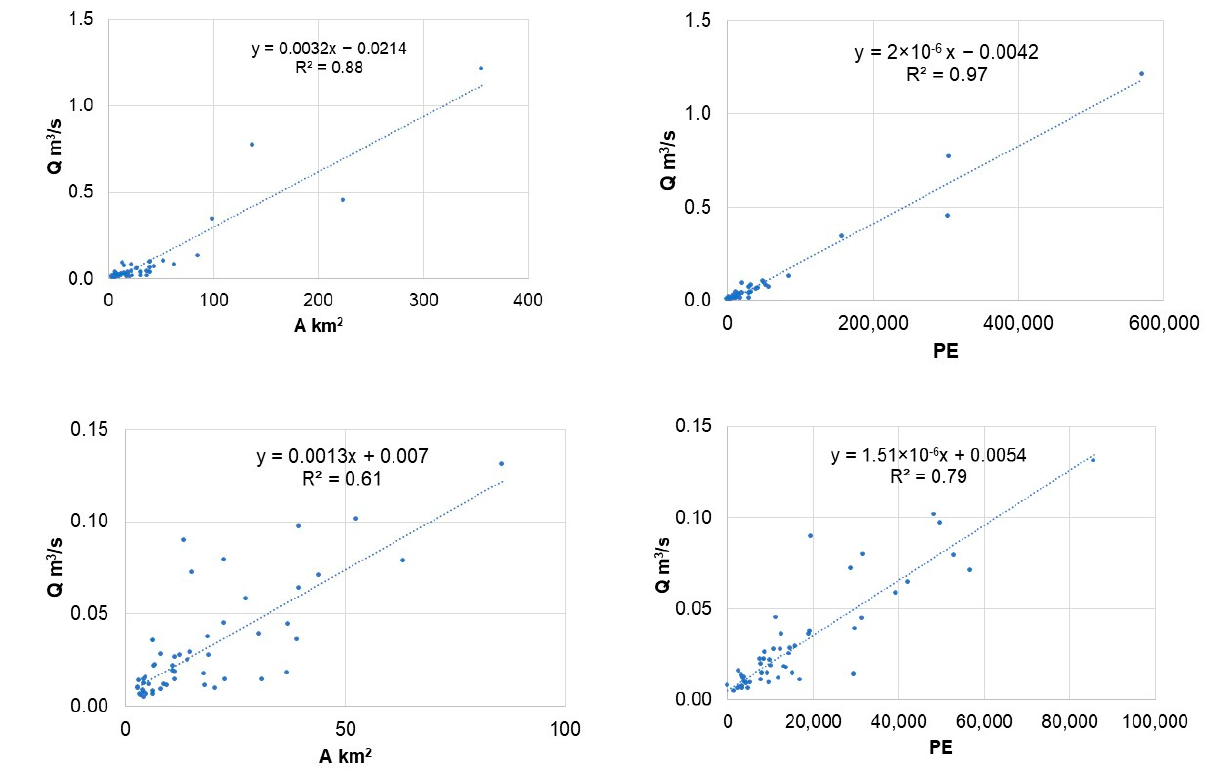
Figure 5. Relationship of mean annual wastewater flow with population equivalent (PE) and col- lection network service area (A, km 2 ). Top —all 58 WWTPs; bottom —small WWTPs (large cities not included).